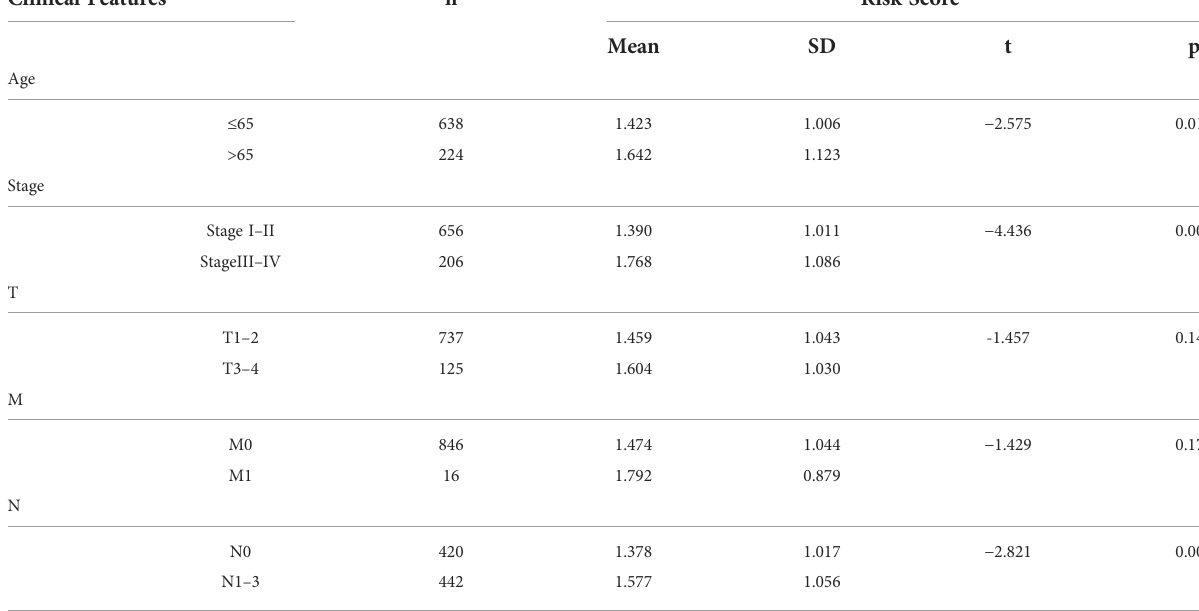
TABLE 3 The relationship between clinical features and risk scores in patients with BRCA in the ARlncRNA model. Clinical